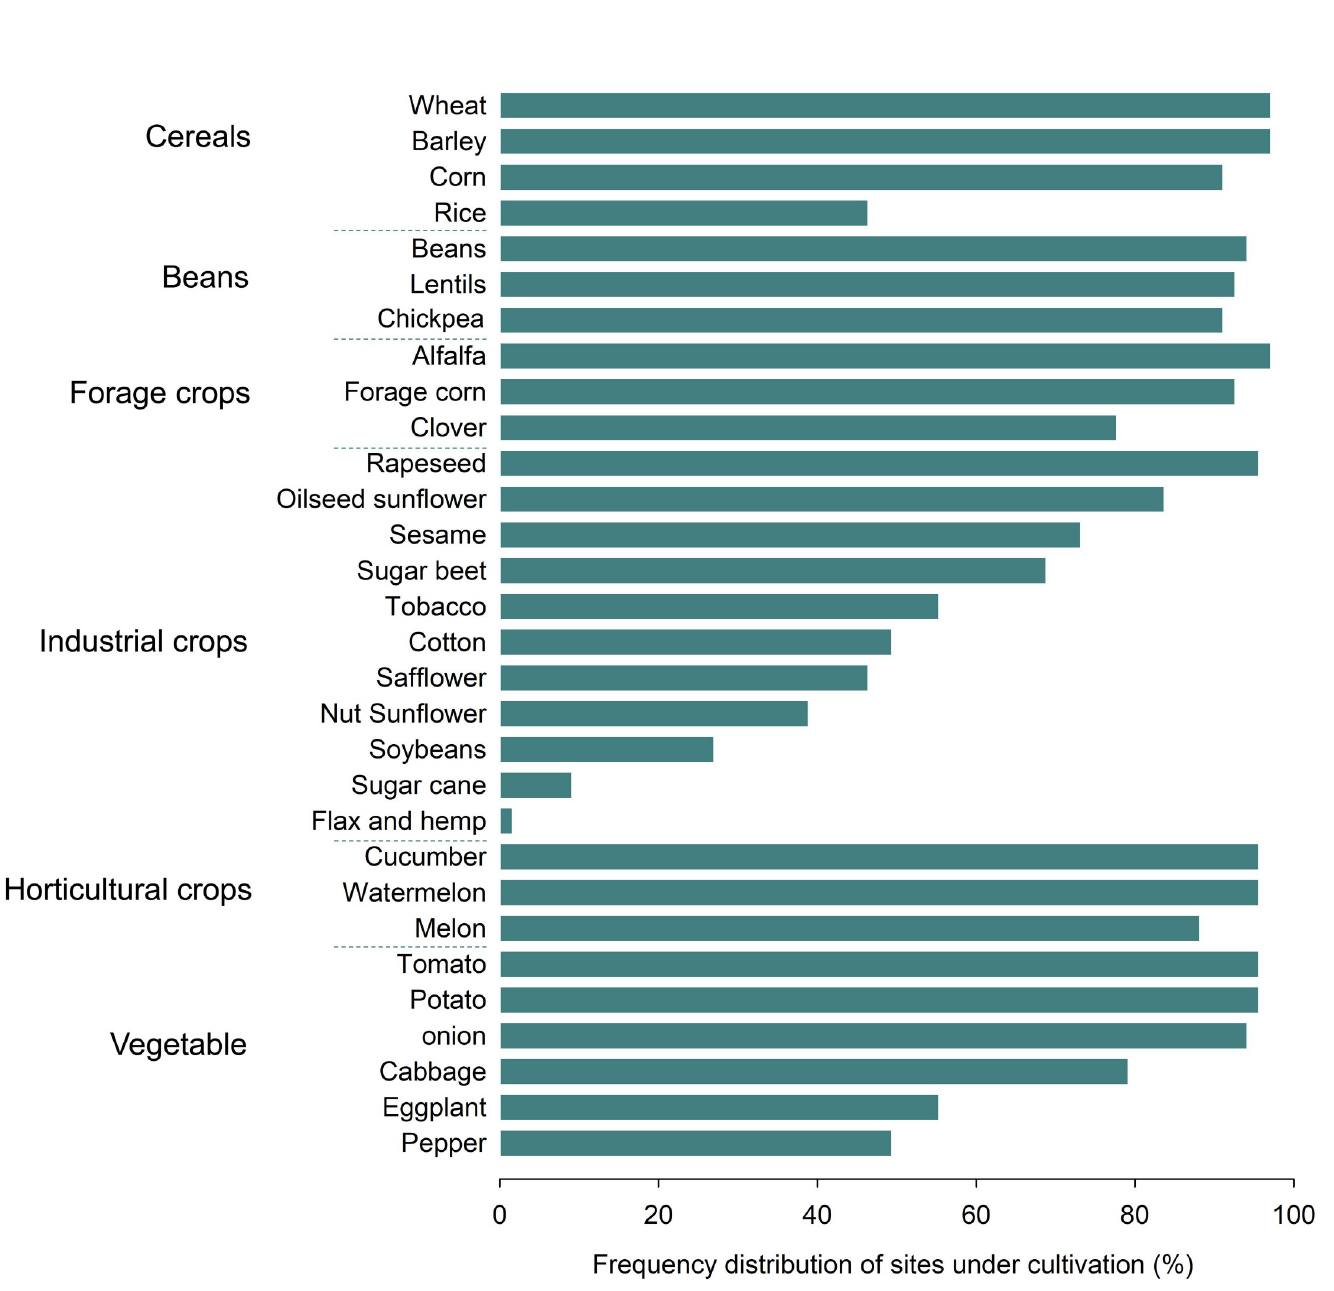
PLOS ONE | https://doi.org/10.1371/journal.pone.0264702 March 11,